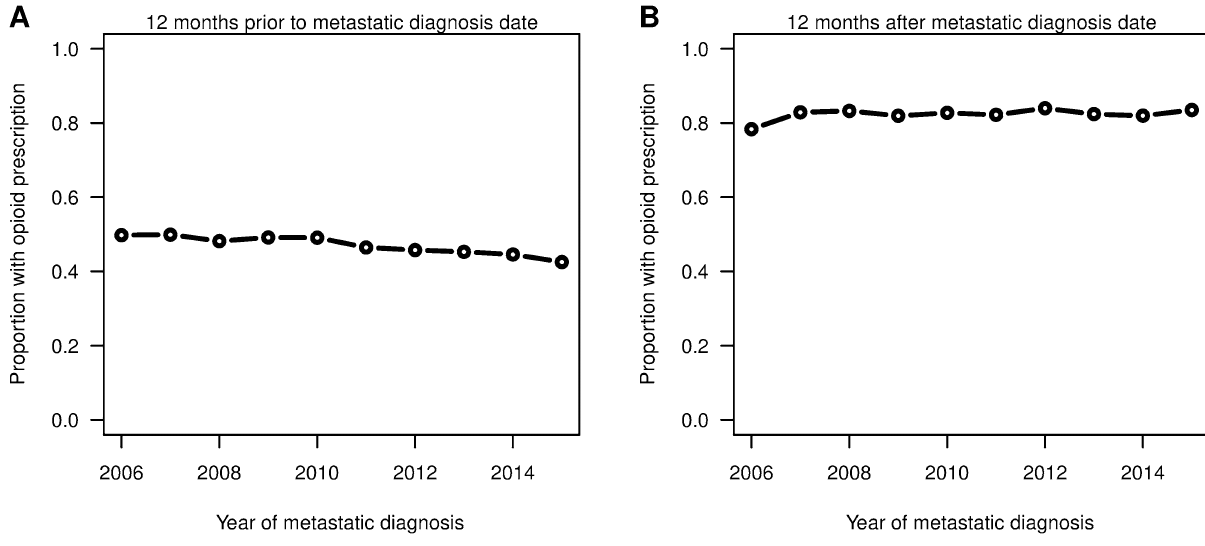
Figure 1. Proportion of patients who filled a prescription for an opioid within 12 months before the metastatic diagnosis date (left) and 12 months after the metastatic diagnosis date (right). Using R software (https ://www.R- proje